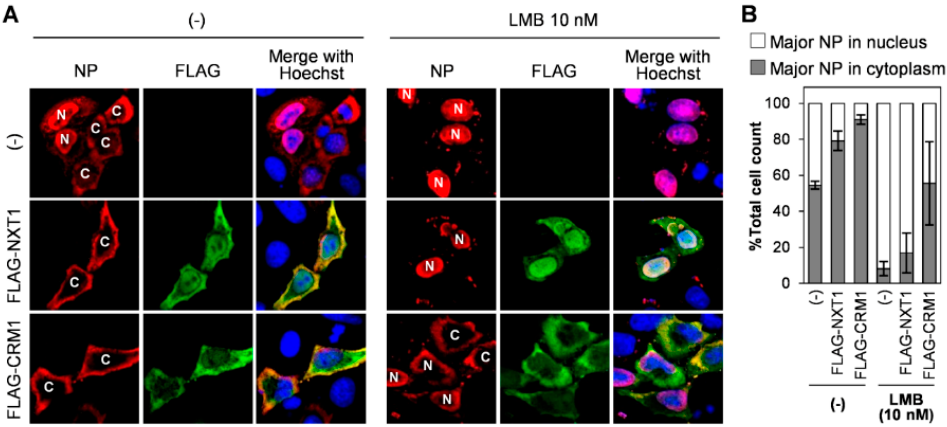
Figure 5. NXT1 promotes the nuclear export of NP via a chromosome region maintenance 1 (CRM1) ‐ dependent pathway. ( A ) HeLa cells were transfected with NP/pCAGGS and